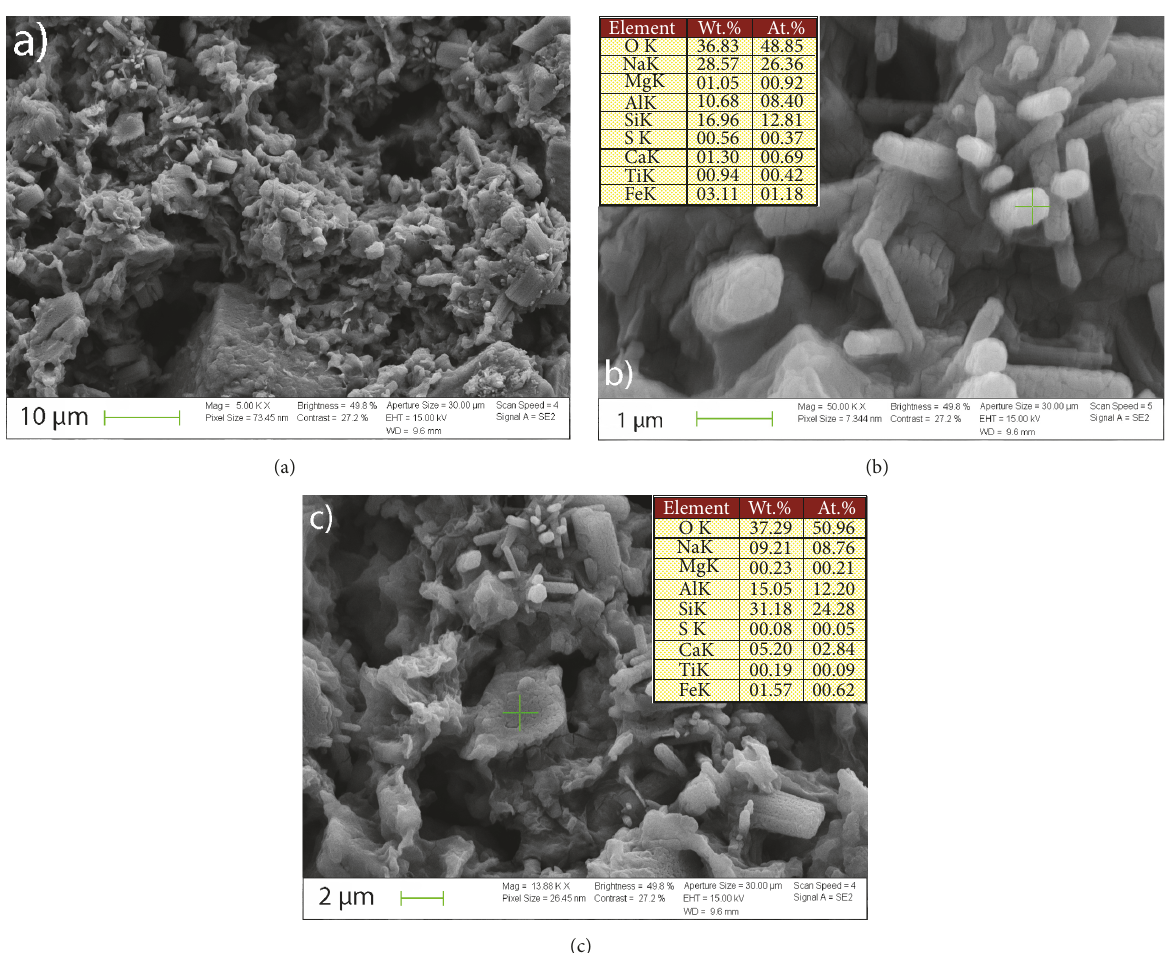
Figure 4: SEM images of specimen 1 cured for 7 days at 87 ∘ C and ambient pressure; (a) pores are visible; (b) needle structures; (c) elemental analysis of a selected